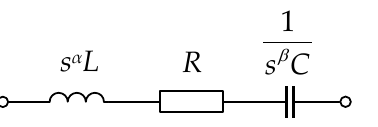
Figure 14. FO impedance model of the human respiratory system [11].